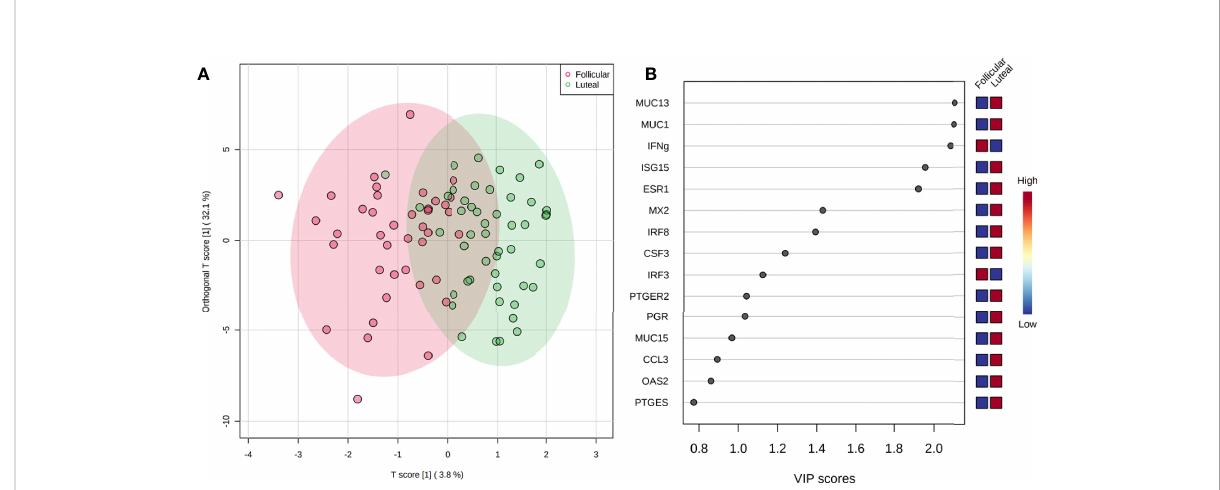
FIGURE 3 Overall gene expression clustering of explants between the estrous cycle phases ( P < 0.001) by OPLS-DA (A) with corresponding VIP plot (B) indicating genes contributing to observed